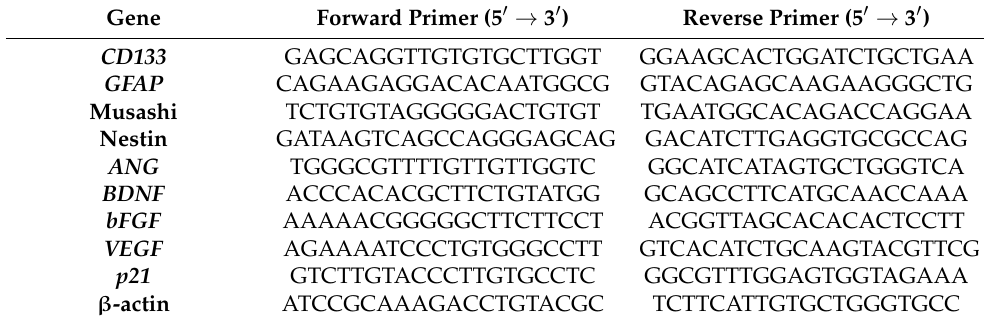
Table 1. Primers used in the real-time polymerase chain reaction